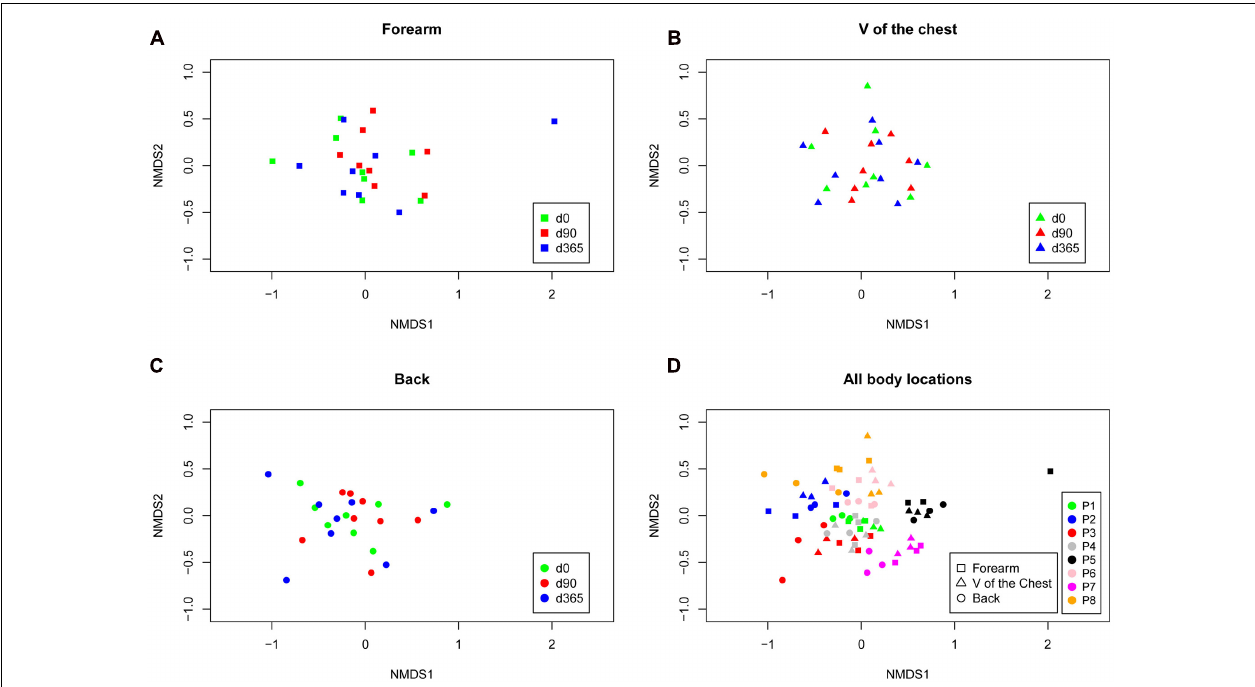
FIGURE 2 | Non-metric ordination plots based on Bray–Curtis distances for each body location forearm (A) , V of the chest (B) and back (C) colored according to the storage period and for all locations (separated by symbols) and storage periods combined colored by the volunteer (P1–P8; D ). Neither calculating each body location individually nor analyzing all locations together revealed a cluster for storage time at − 80 ◦ C. The clustering occured in inter-individual differences [patient p -value = 0.001 ( R 2 = 49%), body location p -value = 0.023 ( R 2 = 4.7%), and storage time p -value = 0.07 ( R 2 = 4.0%) as analyzed with multivariate permutational MANOVA; Adonis in